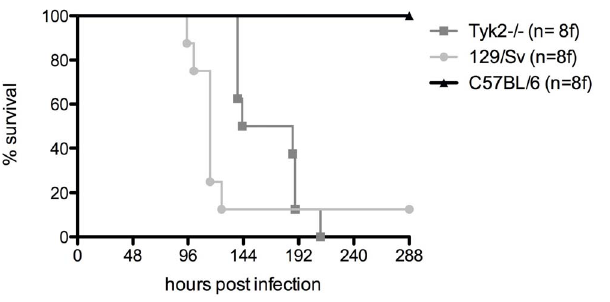
Fig. 1. Survival rates of different mouse genotypes challenged with L. monocytogenes. Mice of the indicated genotypes (n 5 8 mice/group) were infected with 5 6 10 4 cfu bacteria intraperitoneally and survival was monitored over a 12-day